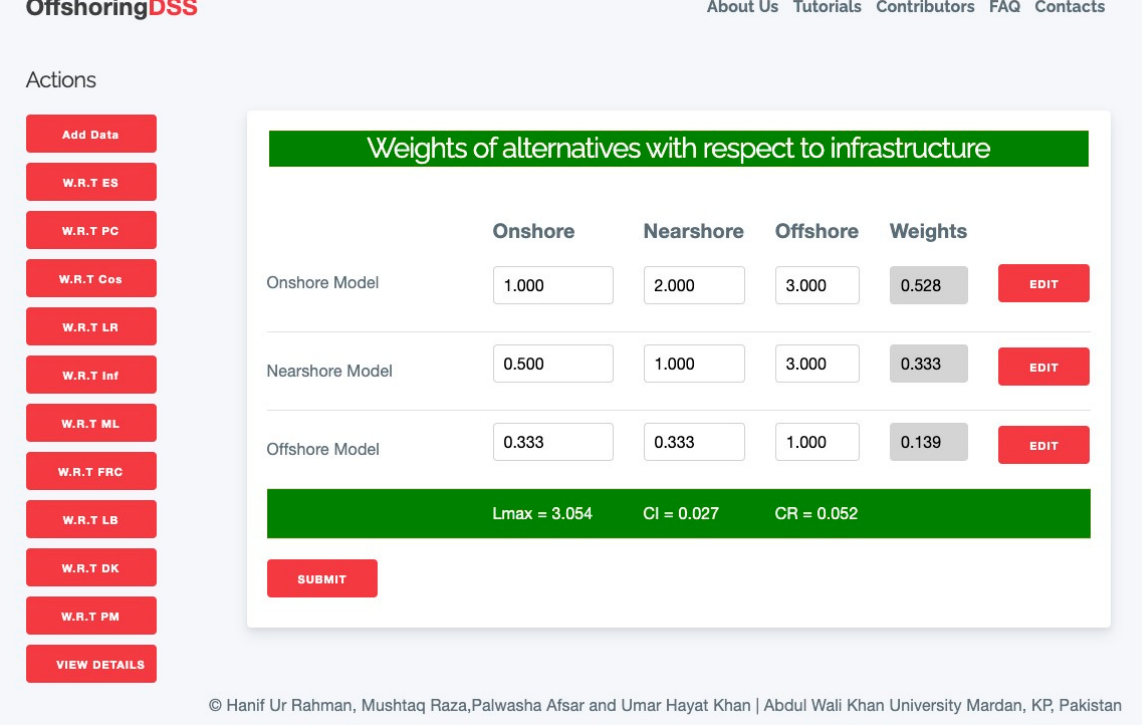
Figure A4. Alternatives weights with reference to Inf and CR.